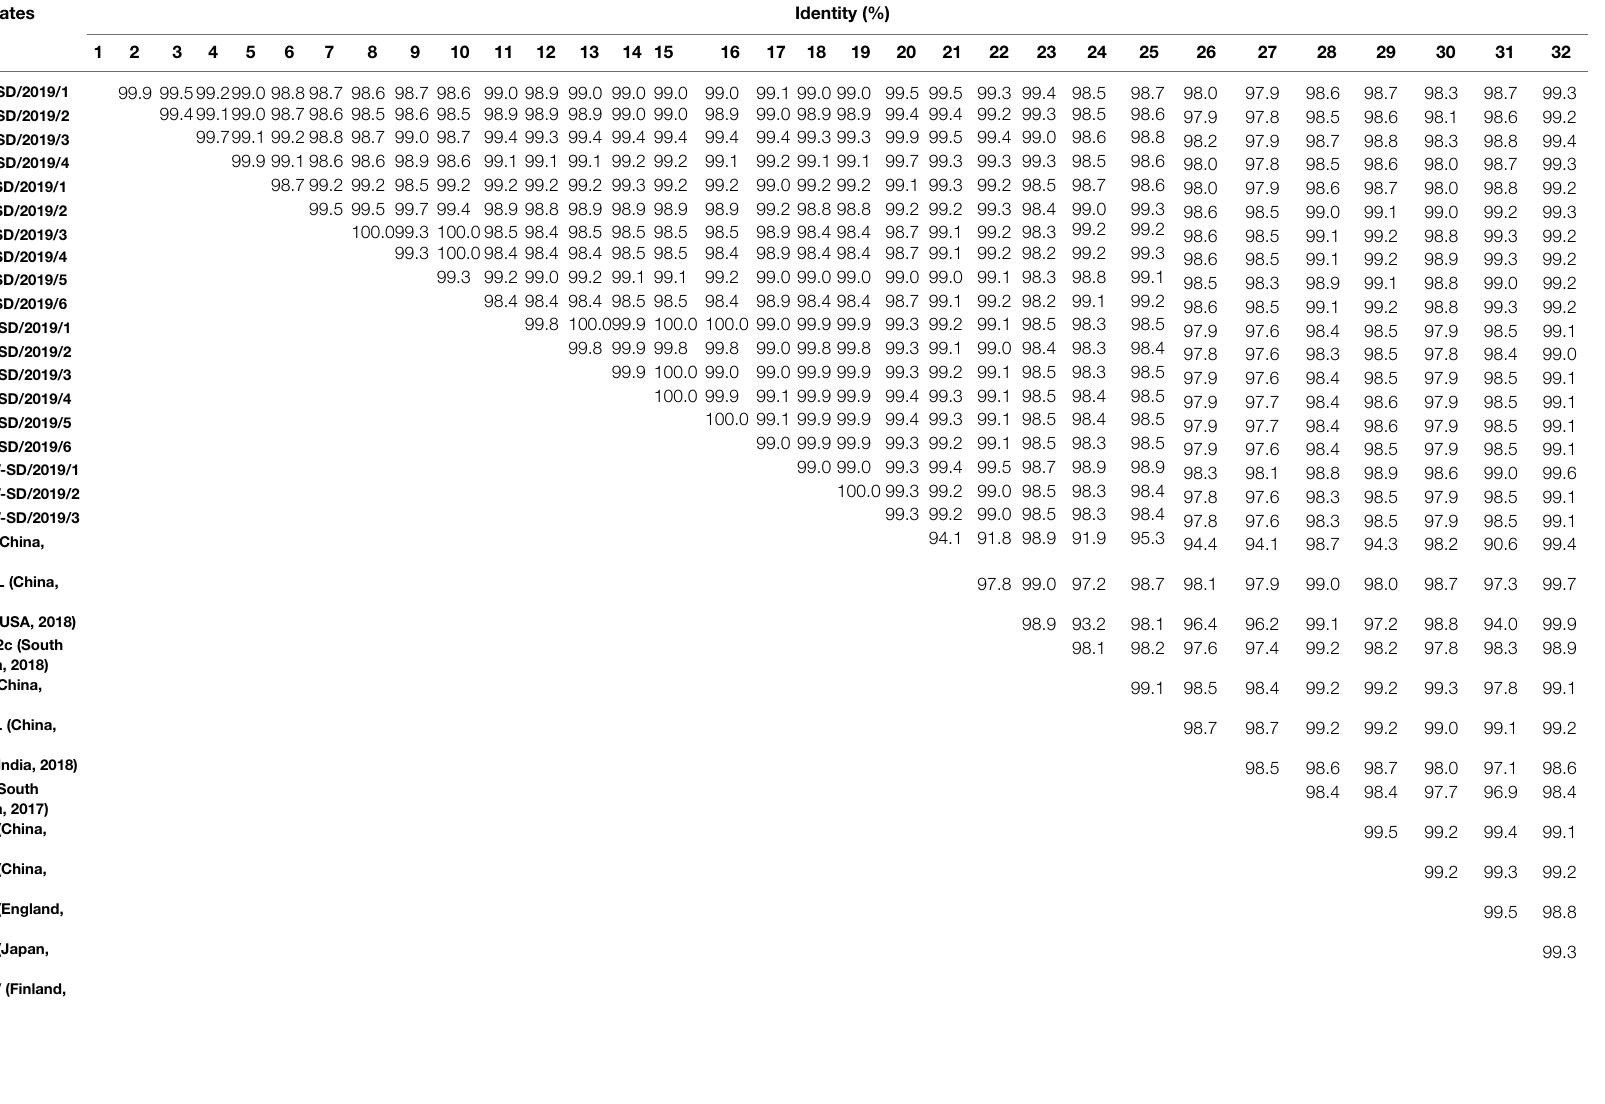
TABLE 3 | Genome nucleotide homology of the isolates and the reference viruses. Isolates Identity